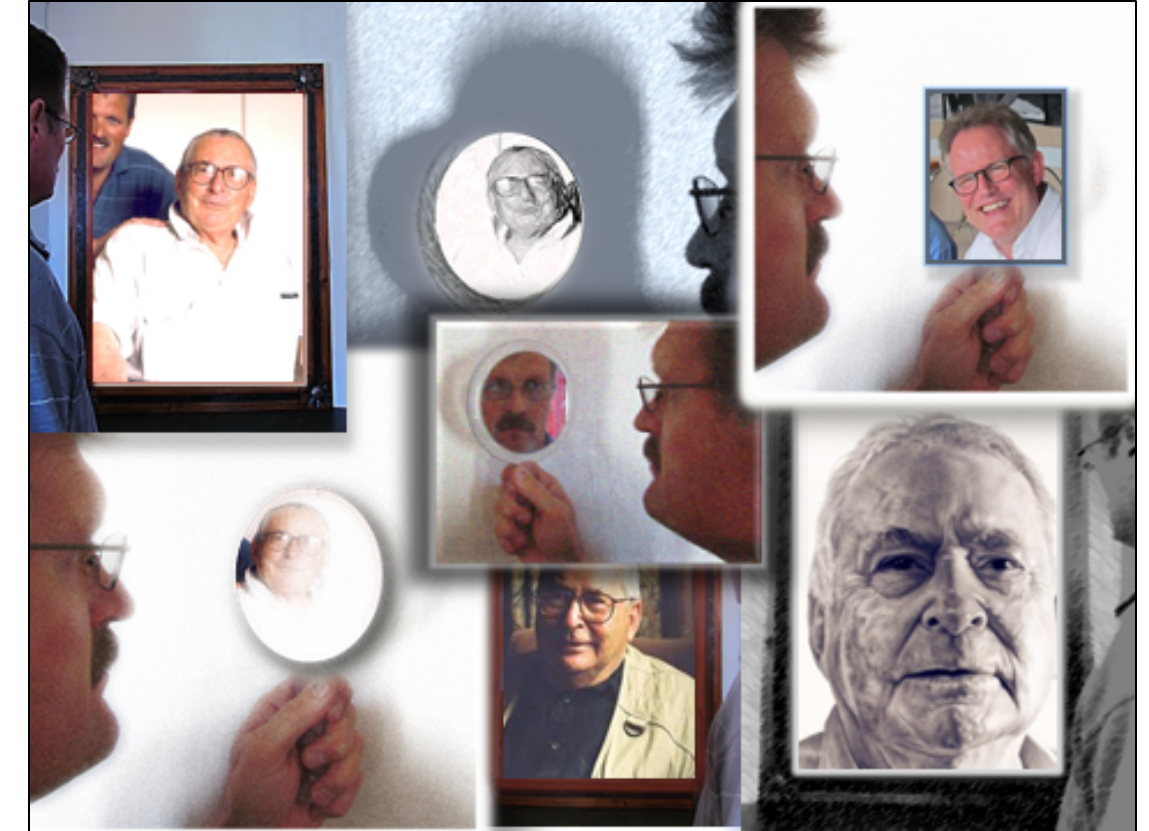
3: ŉ Foto-collage ter uitbeelding van die navorsingsproses (sien bespreking in